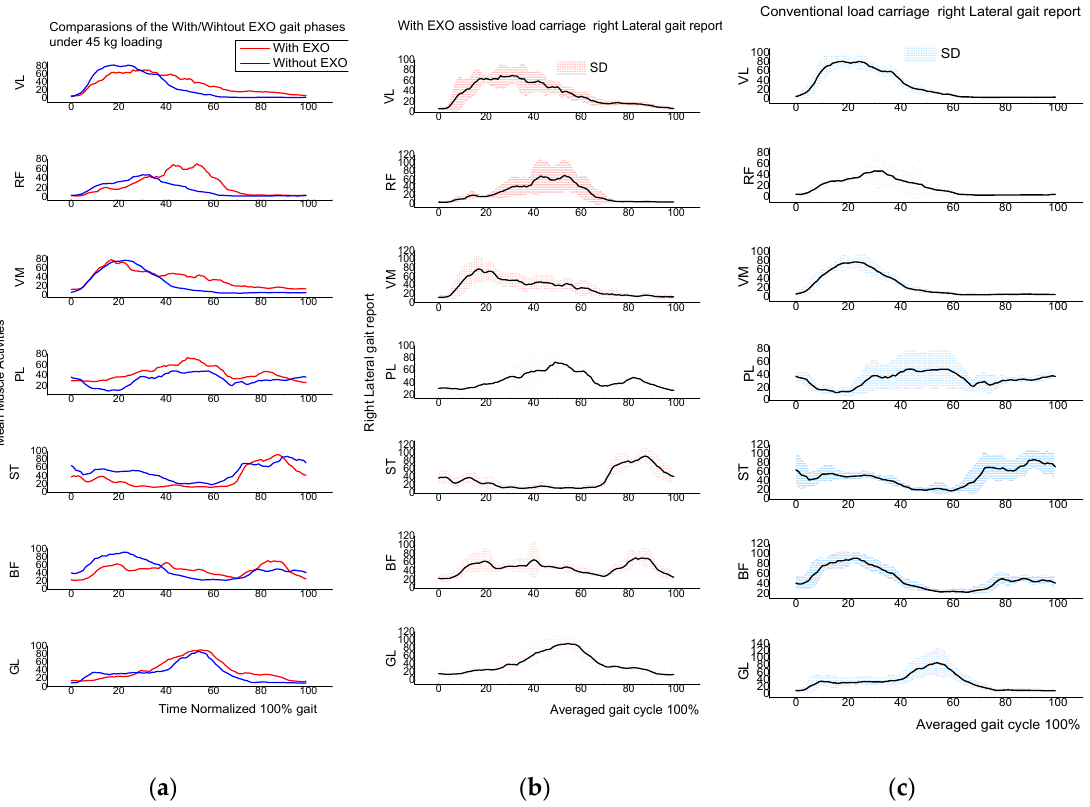
Figure 7. Time normalized EMG gait patterns for the measured right leg muscle groups during with-Exo and without-Exo walking in the case of 45 kg load carriage.